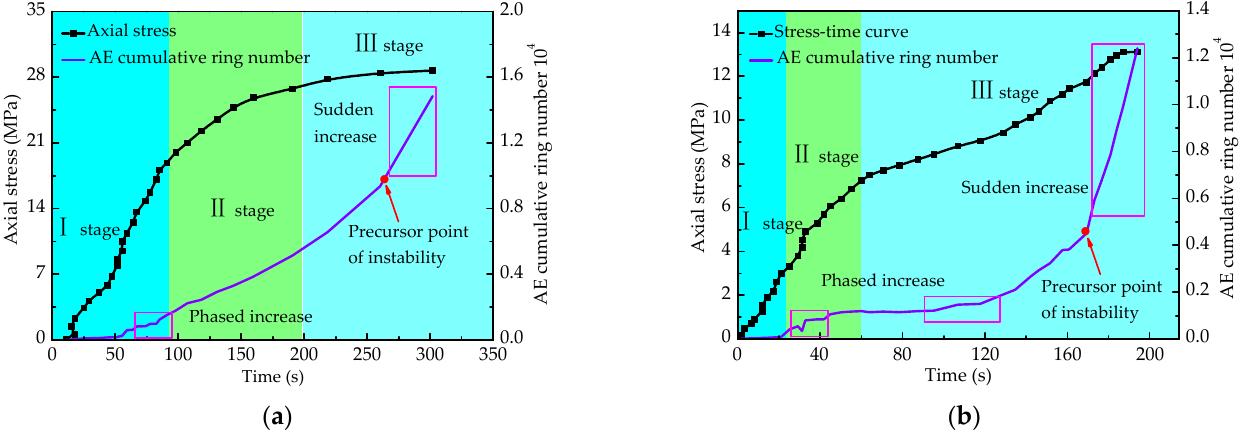
Figure 8. Evolution of AE cumulative ring number under parallel loading: ( a ) Gray samples; ( b ) Carbonaceous samples